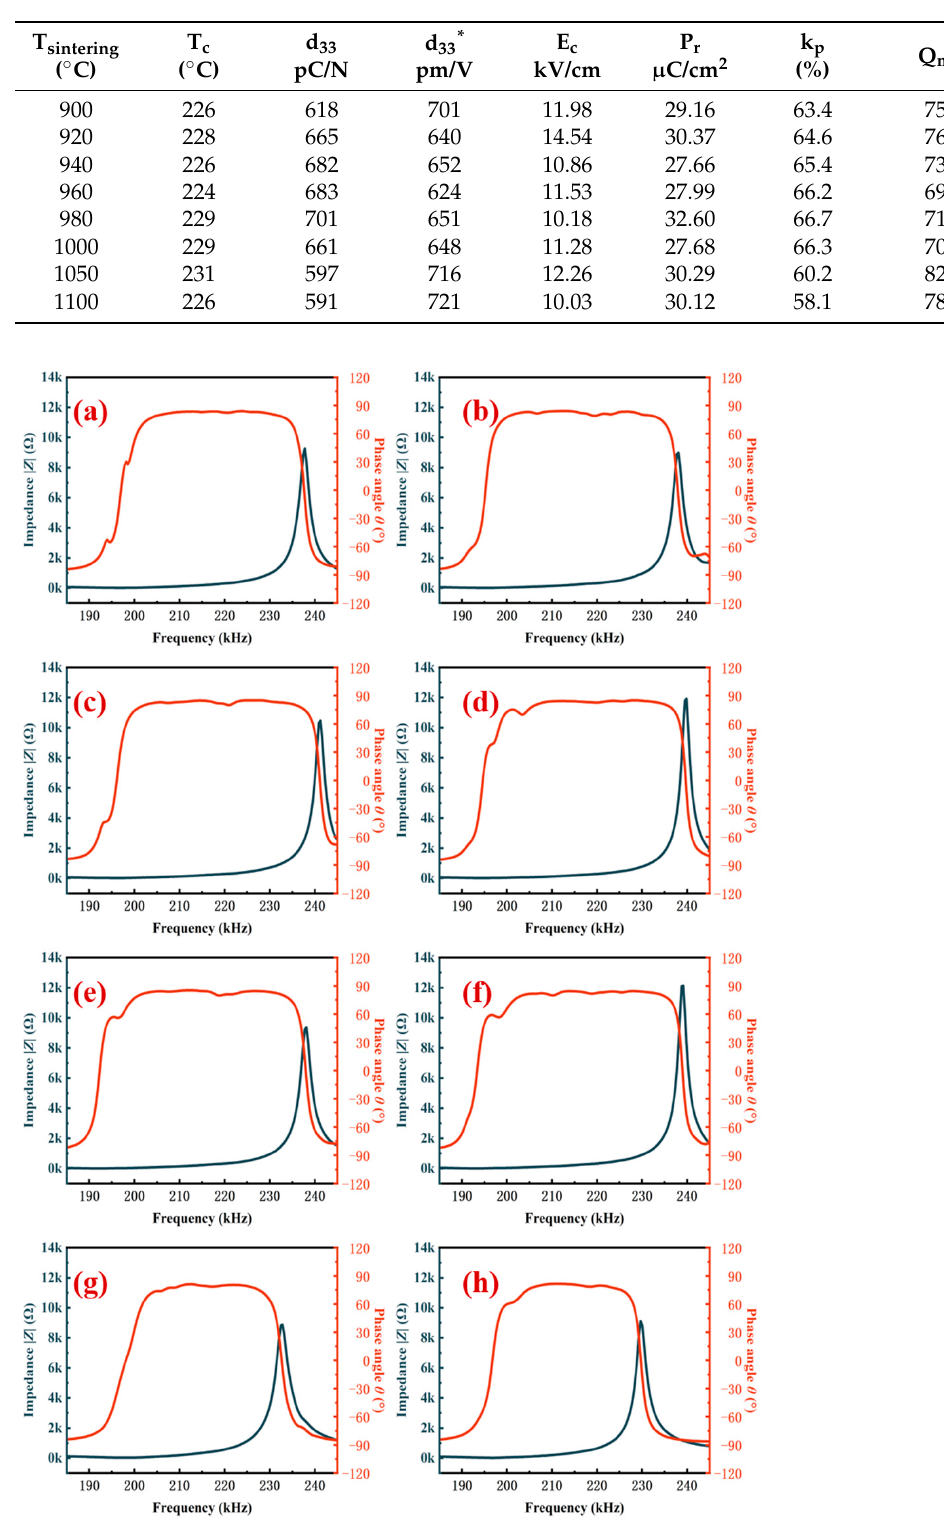
Table 2. The specific values of electrical parameters of the 0.2 wt% Li 2 CO 3 -modified PZT- based ceramics.